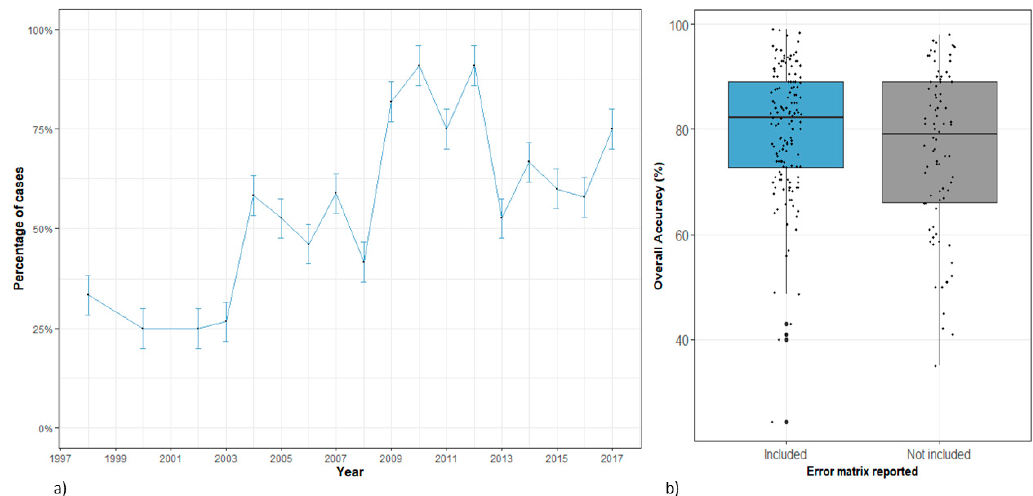
Figure 2. Error matrix reporting in remote sensing literature from 1998–2017, and its relation with the obtained overall accuracy. ( a ) Number of cases that included (or not) an error matrix distributed by year published, ( b ) average accuracy for studies that included (or not) a complete error matrix in the publication.